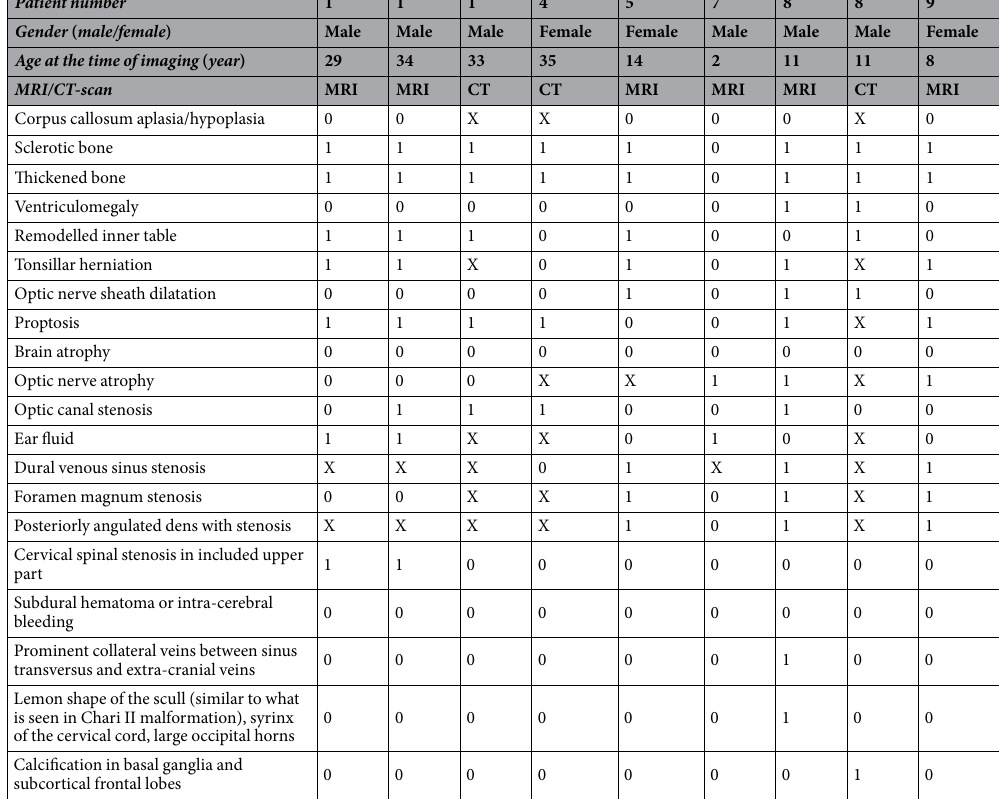
Table 2. Magnetic resonance imaging (MRI) and computed tomography scan (CT) of the skull and brain, in six individuals with SNX10 related intermediate autosomal recessive osteopetrosis (IARO). 1 = present, 0 = not present, X = feature not possible to